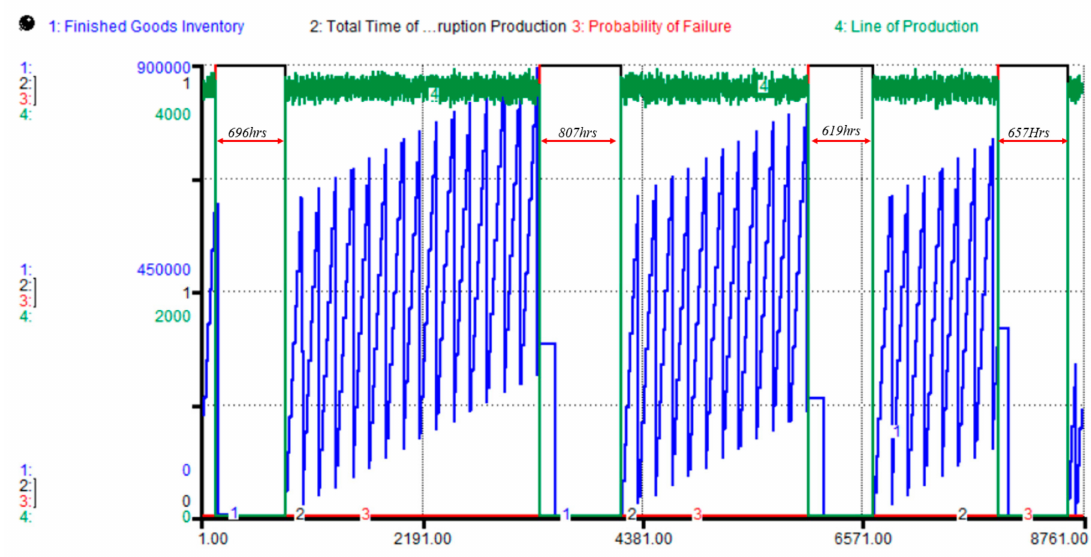
Figure 7. Disruption time in line of production with four